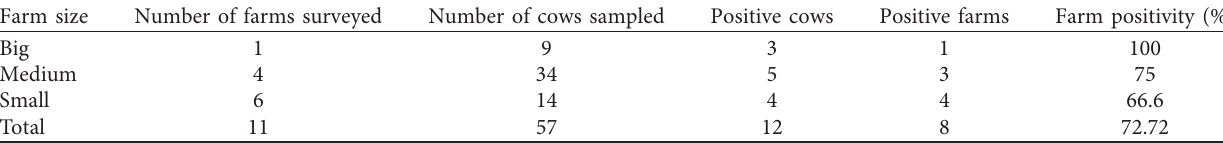
Table 2: Prevalence of Staphylococcus aureus at farm/herd level.